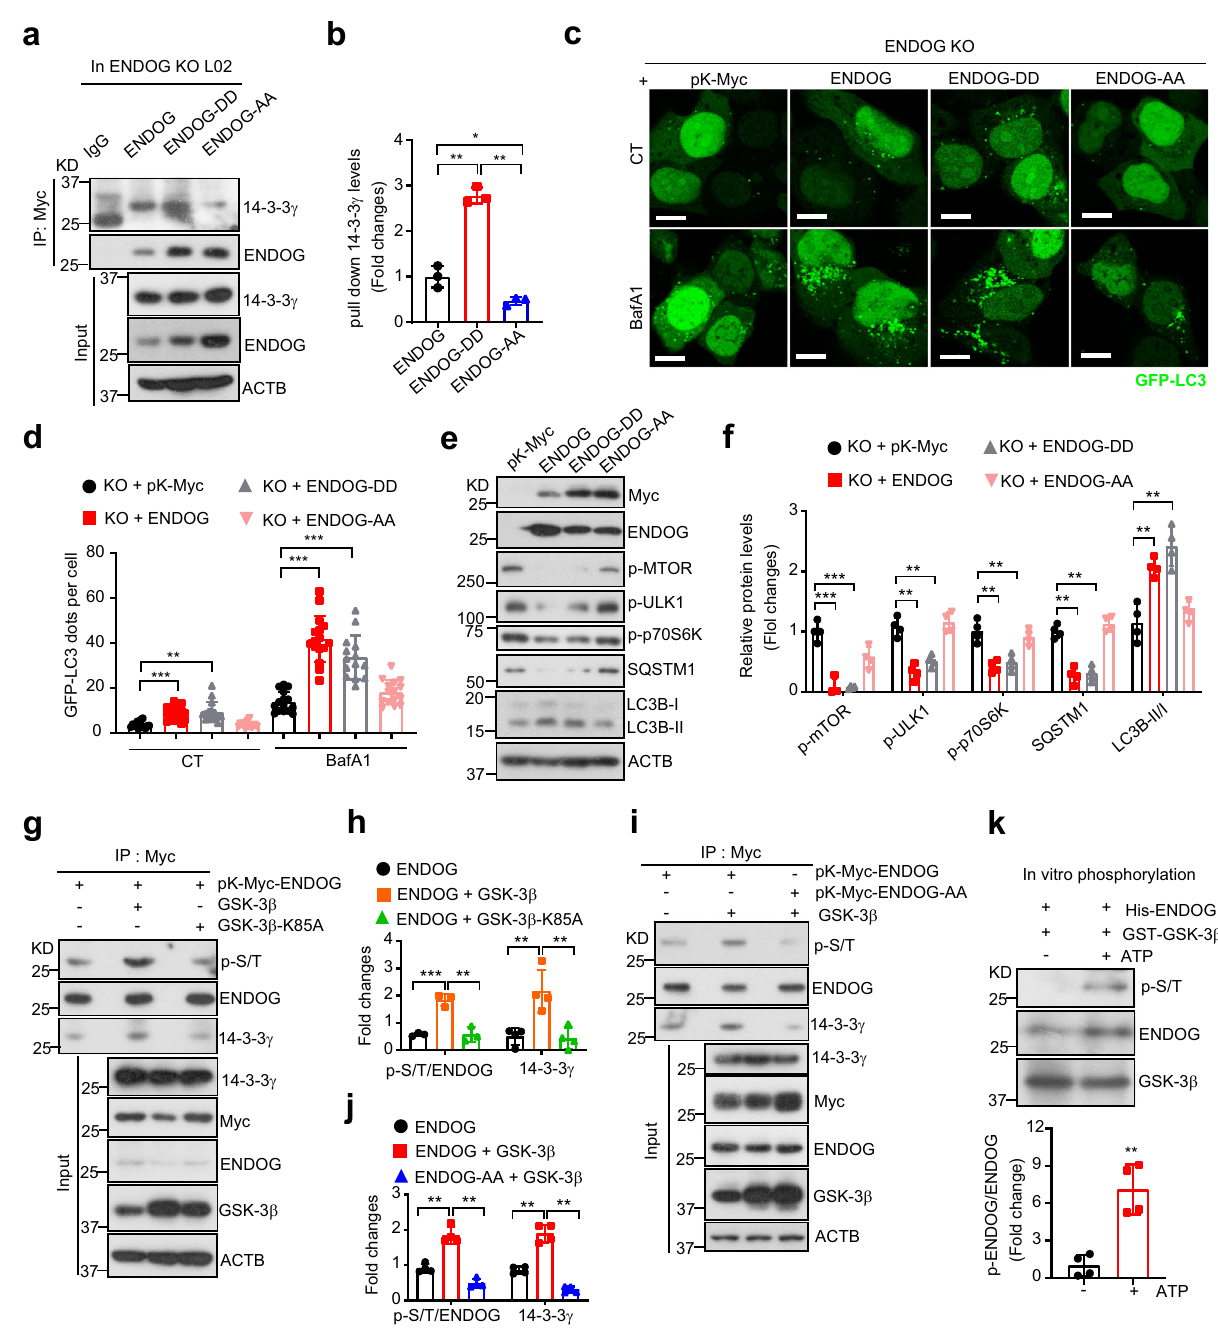
Fig. 4 GSK-3 β mediated phosphorylation of ENDOG at T128/S288 is necessary for ENDOG-induced autophagy. a , b Co-IP experiments ( a ) and quantitative results ( b ) showed that phosphorylation of ENDOG at T128/S288 is necessary for its interaction with 14-3-3 γ (overexpression of wild-type and mutant ENDOG in the ENDOG knockout L02 cell; WT: wild-type; DD: T128D/S288D; AA: T128A/S288A; n = 3 independent experiments; data are presented as mean values ± SD, * p < 0.05; ** p < 0.01). c , d Representative immuno fl uorescence images of GFP-LC3 puncta ( c ) and respective quantitative results ( d ) (ENDOG knockout cells transiently transfected with the wild-type and mutant ENDOG for 48 h and treated with or without 100 nM BafA1 for 6 h; scale bar = 10 μ m; n = 100 independent cells examined over three independent experiments; data are presented as mean values ± SD; ** p < 0.01, *** p < 0.001). e , f Western blots ( e ) and quantitative results ( f ) of mTOR pathway and autophagy-related proteins. ENDOG-knockout cells were transiently transfected with the wild-type and mutant ENDOG for 48 h ( n = 4 independent samples; data are presented as mean values ± SD; ** p < 0.01, *** p <